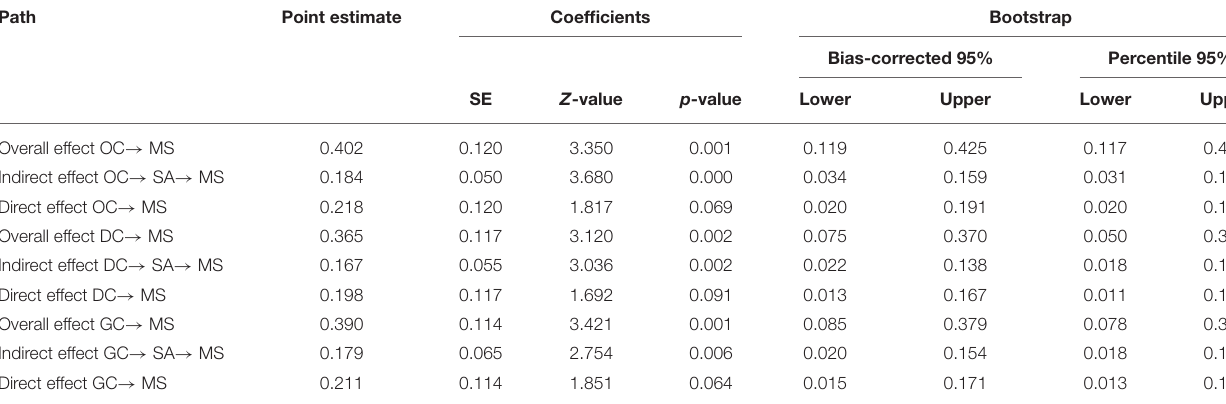
TABLE 6 | Empirical testing of mediating effects.